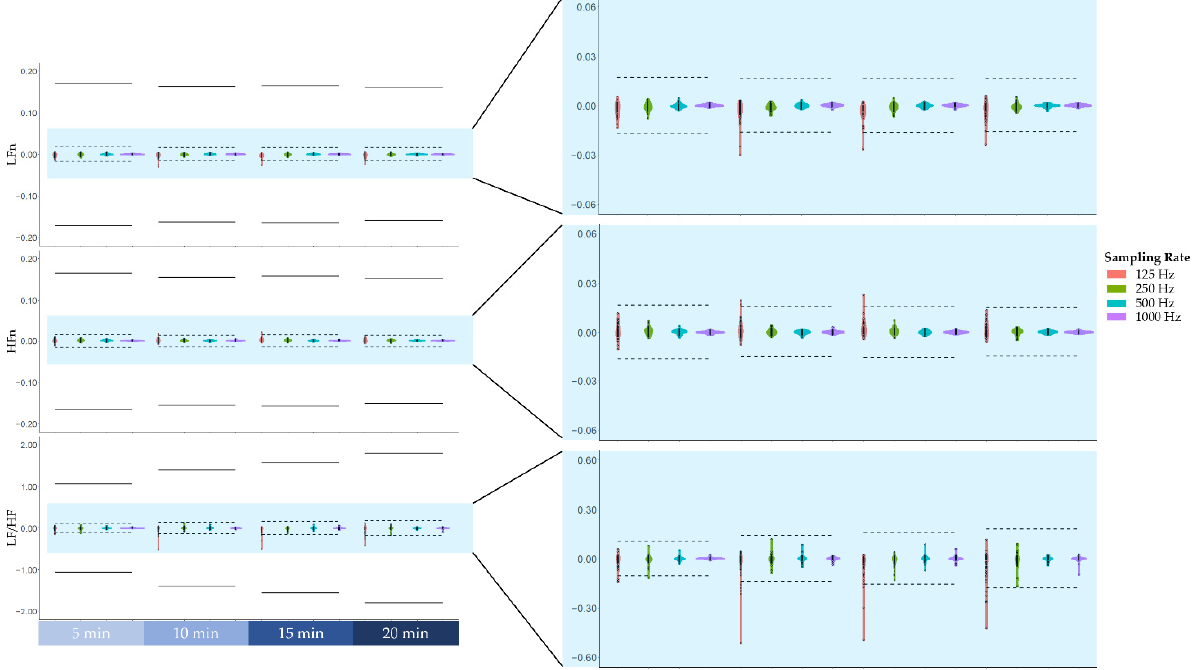
Figure 3. The difference scores between the frequency-domain heart rate variability features derived from the original 2000 Hz data and features derived from down-sampled data (i.e., 1000 Hz, 500 Hz, 250 Hz, 125 Hz). From top to bottom, difference scores of low-frequency power normalised to total power (LFn), high-frequency power normalised to total power (HFn), and the ratio of low-frequency power to high-frequency power (LF/HF). Note that the solid lines represent ± 1 standard deviation of the features derived from the 2000 Hz data, whereas the dashed lines represent ± 1/10 standard deviation.